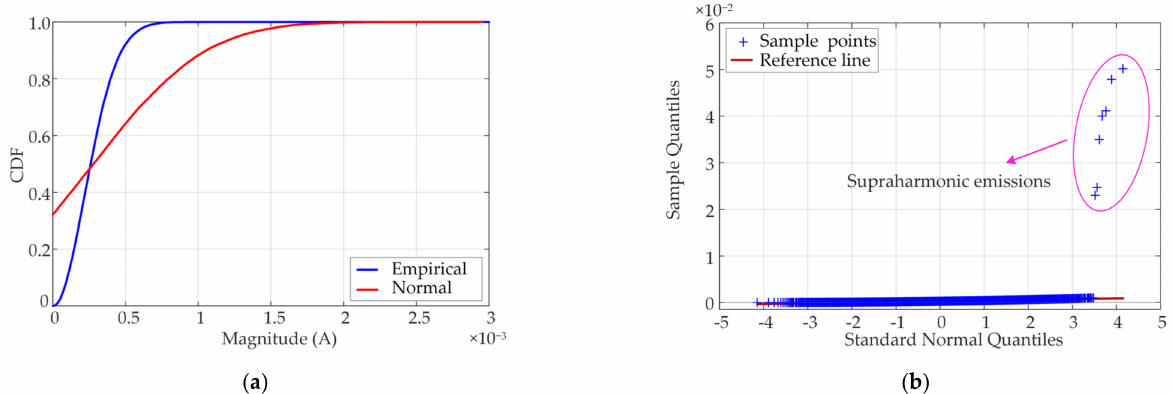
Figure 5. The frequency-domain distribution with supraharmonic signals. ( a ) CDF curve of the normal distribution and empirical distribution; ( b ) Data distribution Q–Q plot.